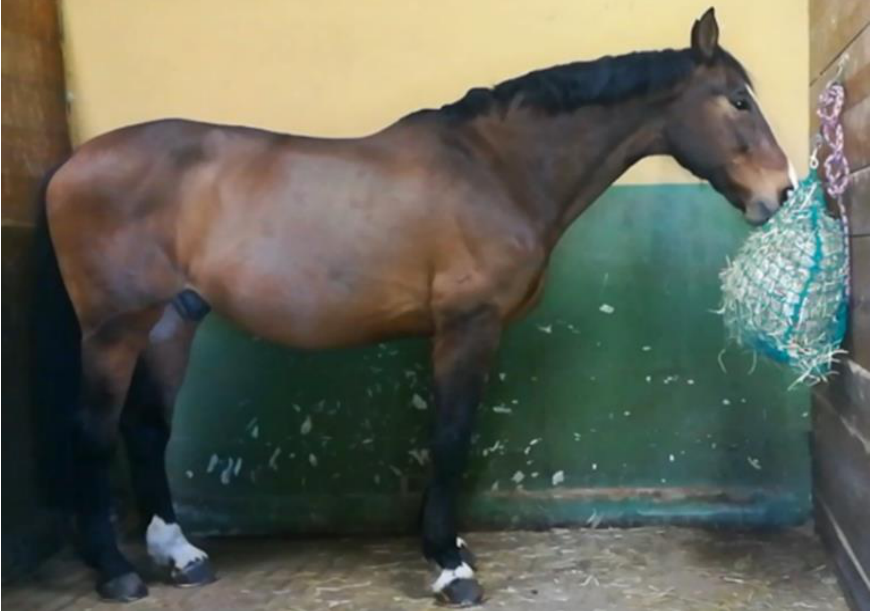
Figure 3. High hay net position (HP). The bottom edge of the hay net is level with the horse’s elbow.